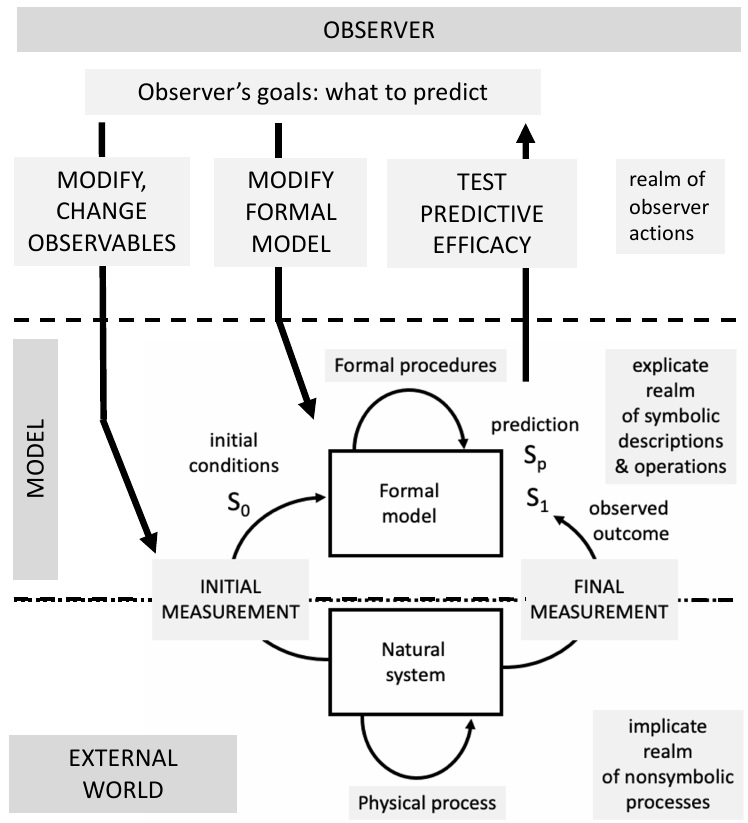
Figure 2. Observer mechanics of empirical, hypothetico-deductive models. Bottom: Hertzian commutation diagram for testing predictive efficacy.